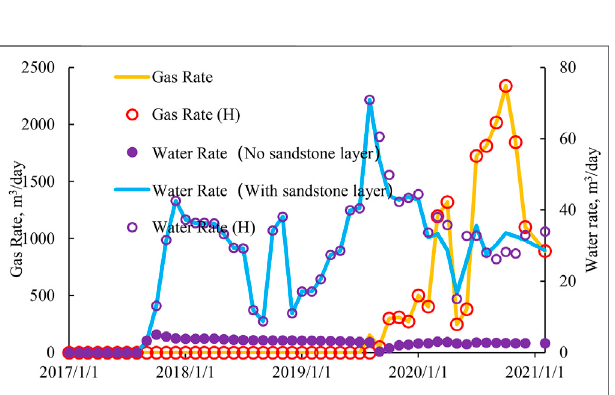
FIGURE 7 | History matching result of daily gas – water and cumulative gas – water is signi fi cantly improved when the aquifer is considered.